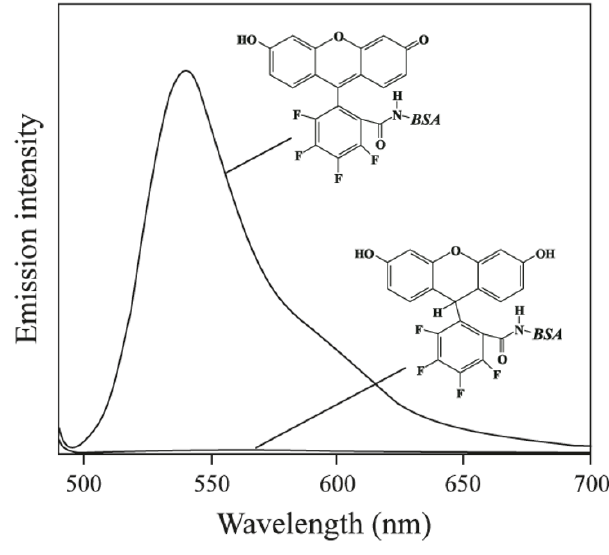
Figure 1 Structures and emission spectra of OxyBURST Green H 2 HFF BSA before (lower curve) and after (upper curve) oxidation in the presence of horseradish peroxidase (HRP) and hydrogen peroxide (H 2 O 2